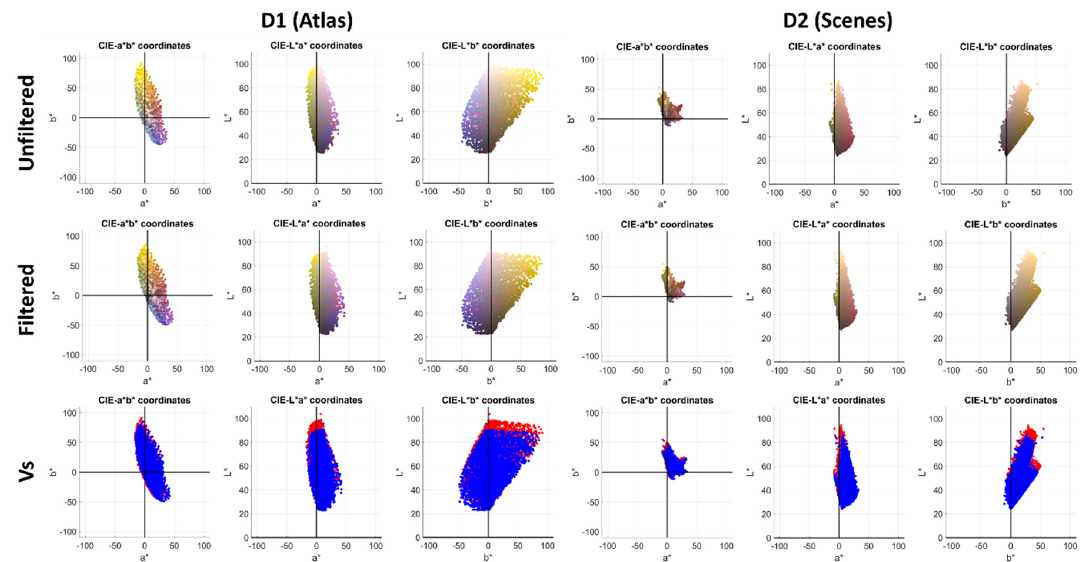
Figure 6. L*, a*, b* data clouds for the protanomalous simulated observer. Left: D1 dataset. Right: D2 dataset. First row: unfiltered; second row: filtered; third row: both filtered and unfiltered distributions in the same graph (red = unfiltered, blue = filtered).